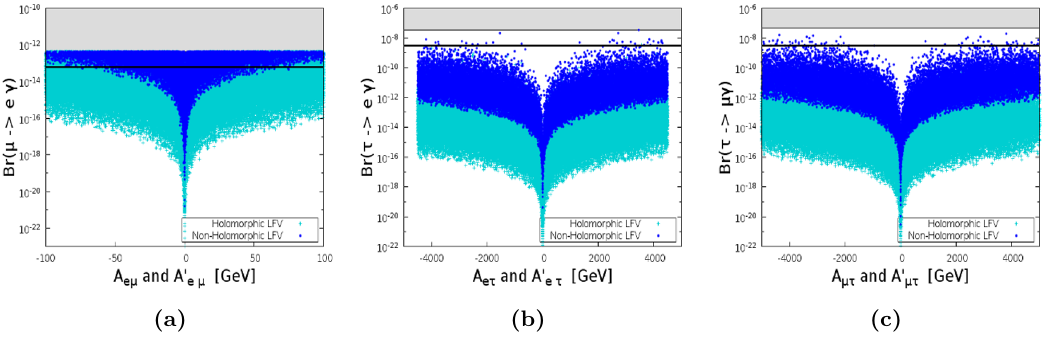
Figure 4. Branching ratios of l j l i (cid:13) as a function of A ij in cyan and A 0 in blue after satisfying ij ! the charge breaking bound and are checked through the other collider bounds viz. eq. (5.1) and table 1. The gray shaded regions and black horizontal lines in each plot denote the present exclusion region and future announced sensitivity of the corresponding channels.